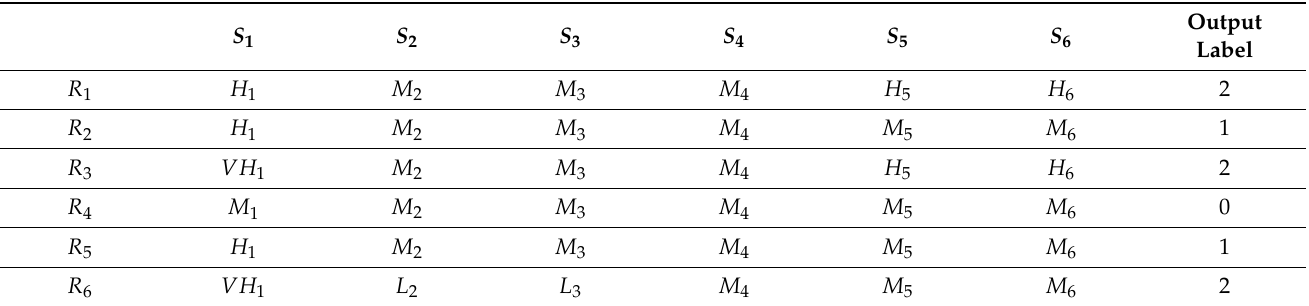
Table 2. The fuzzy rule base assumes that the medical examination results of six gestational women have been concluded to be diagnosed by